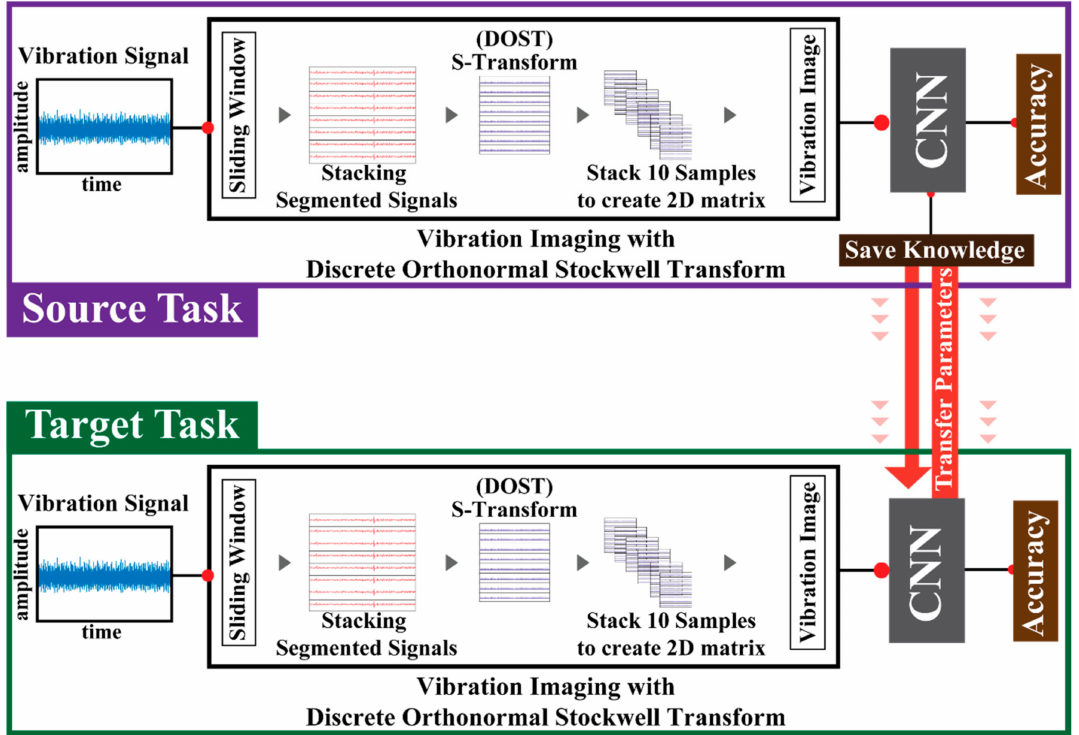
Figure 1. Detailed process of the proposed